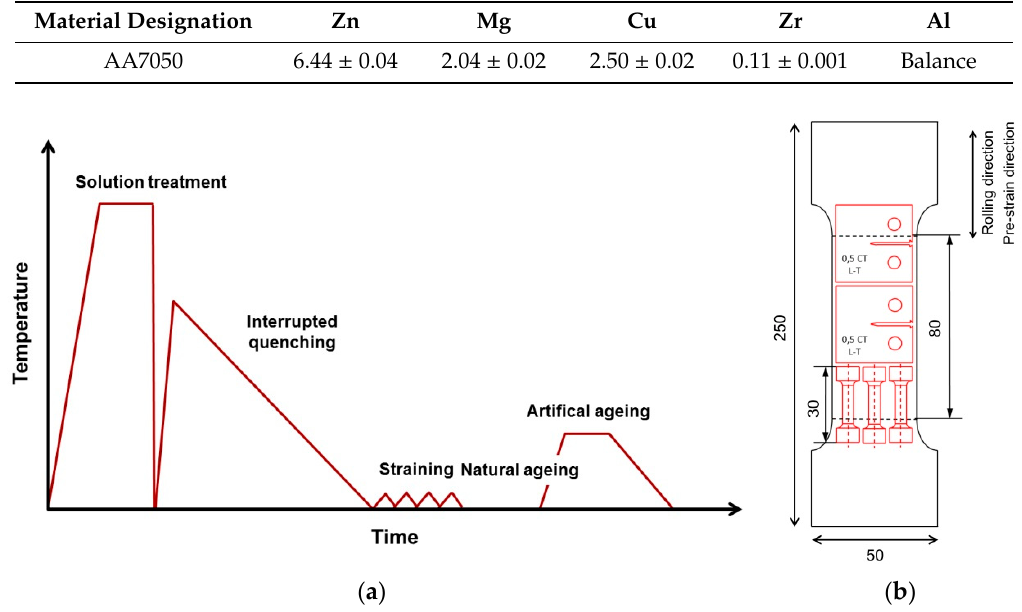
Table 1. Overall chemical composition (wt%, average of 4 measurements) of the material investigated.